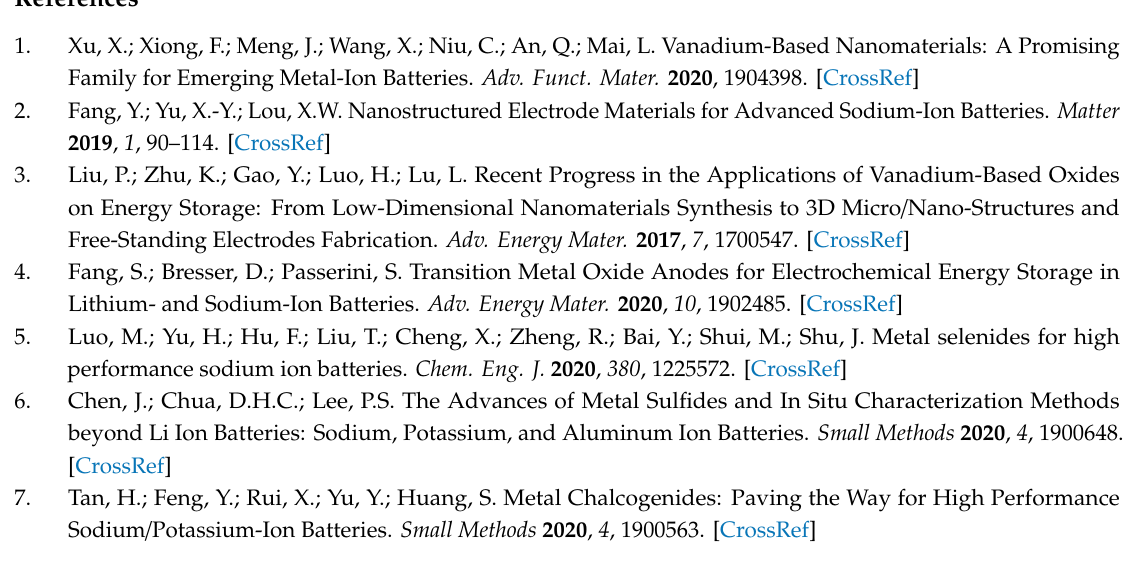
Figure S1: TGA analysis of synthesized bare CoV2O4 and rGO-wrapped CoV2O4 materials; Figure S2: V K -edge X-ray absorption near edge structure spectroscopy (XANES) of CoV2O4 powder and the references of V, VO2, V2O3, and V2O5 spectra; Figure S3: Enlarge 2 values of ex-situ XRD analysis of CVO electrode